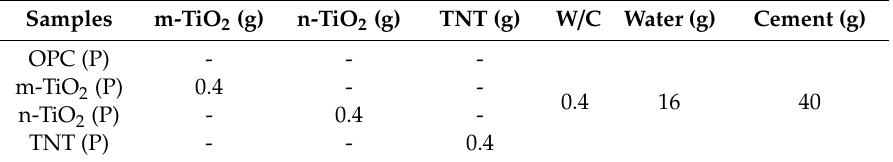
Table 3. Mix proportion of cement paste.